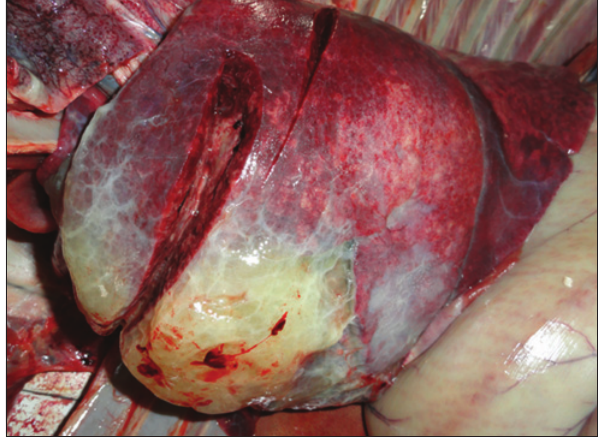
Figure-2: Ovine pulmonary adenocarcinoma affected sheep lung showing pearly-white, hard nodule.